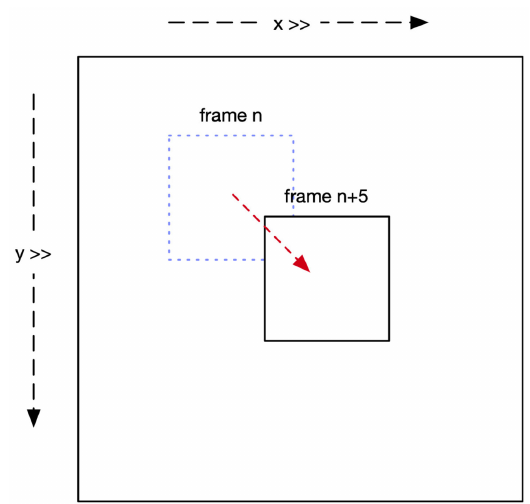
Figure 7. Vehicle’s movement detection.